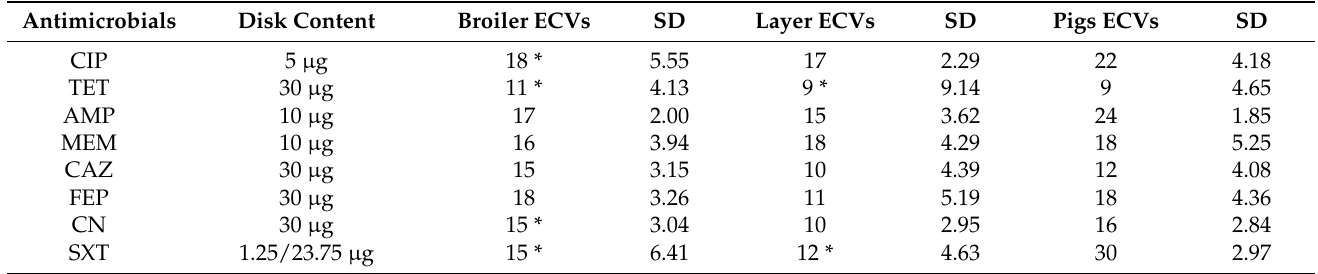
Table 4. ECVs of tested antibiotics against E. coli .